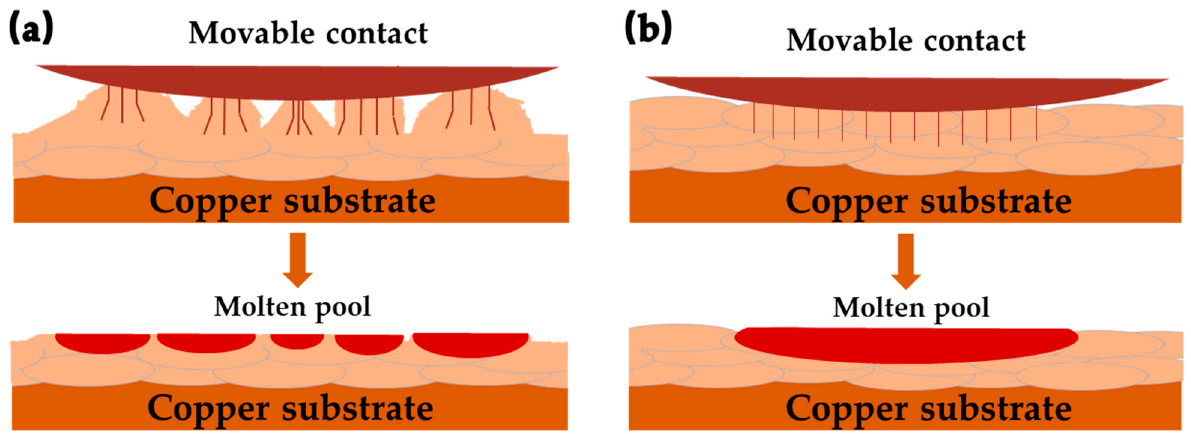
Figure 8. The schematic diagrams of surface morphology dependent erosion process: ( a ) rough surface would induce smaller molten pools, and ( b ) smooth surface with larger molten pool.